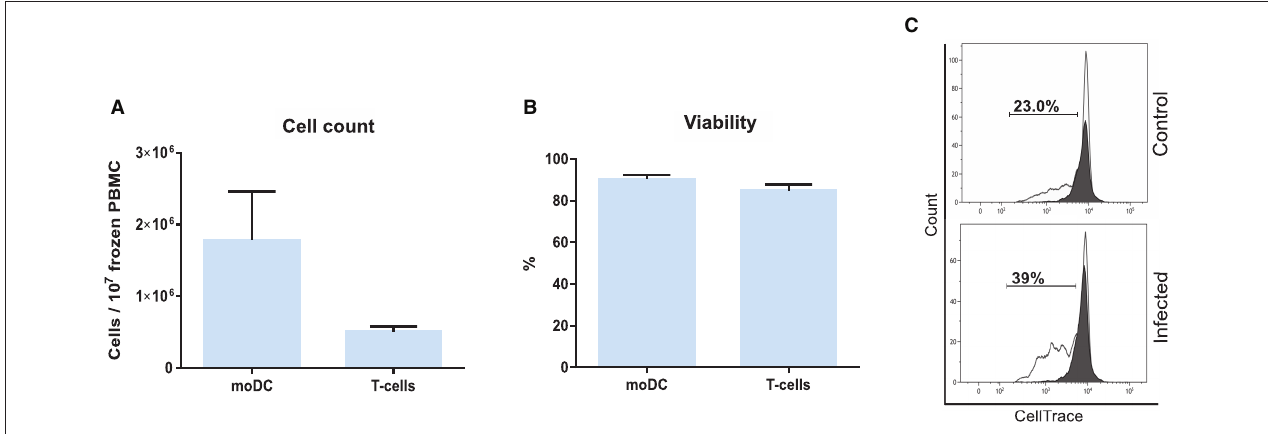
FIGURE 9 | Antigen presentation assay using frozen PBMC. (A) moDC and T-cell count per 10 7 frozen PBMC. (B) Cell viability. (C) The percentage of T lymphocytes proliferation was analyzed by flow cytometry. Control (upper) and infected (lower) graphs correspond to lymphocytes co-cultured with infected or non-infected moDC. Black and white peaks correspond to lymphocytes alone (non-proliferating control) and exposed to moDC, respectively. The gates indicate the percentage of proliferating lymphocytes. Histograms show the results of one representative sample out of three independent replicates from different animals. Error bars represent